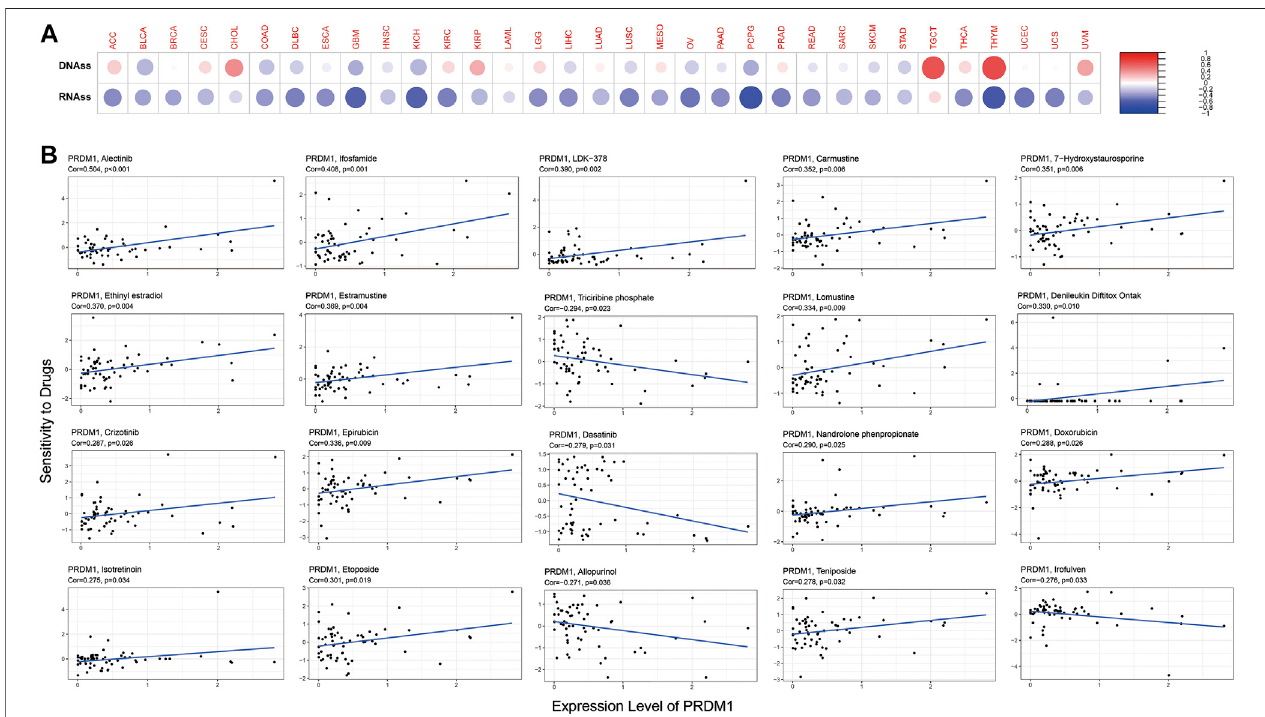
FIGURE 8 | PRDM1 expression, cancer stemness and drug response. PRDM1 expression was found to be positively correlated with cancer stemness in CHOL, KIRP, TGCT, THYM and UVM ( Figure 8A ). The correlation between PRDM1 expression and predicted drug response was displayed in Figure 8B .